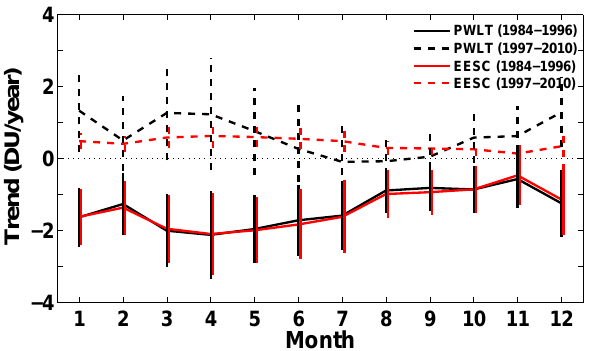
Fig. 3. The monthly ozone trends derived from the combined Dob- son and SAOZ total column ozone measurements. The black and red curves represent the PWLTs and EESC-based ozone trends, respec- tively. The solid and dashed lines denote ozone trends over the pe- riods 1984–1996 and 1997–2010, respectively. The error bars cor- respond to the 95% confidence